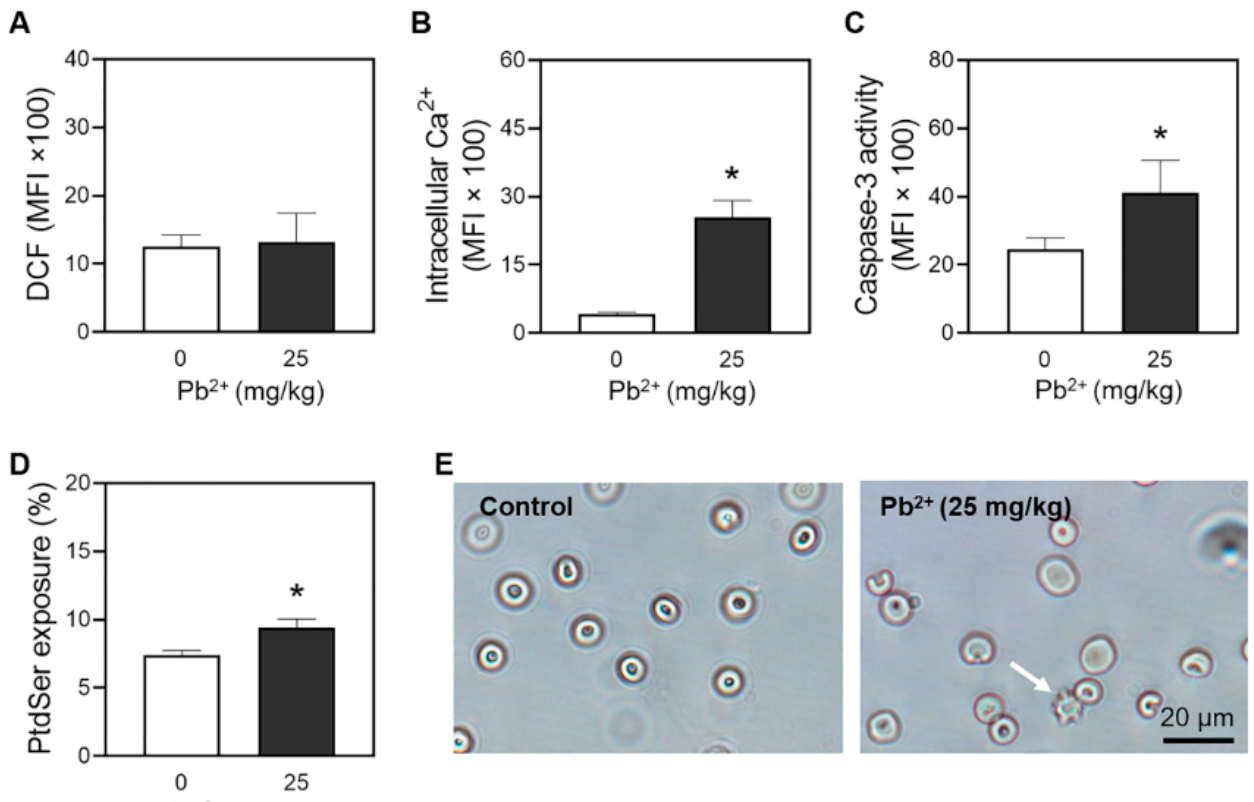
Figure 6. Pb-induced eryptosis in mice. After 25 mg/kg of Pb was exposed to mice for 1 h, ( A ) ROS, ( B ) intracellular calcium, ( C ) caspase 3 activity as well as ( D ) PtdSer exposure of erythroid cells in mice were all detected. In addition, ( E ) shape changes of erythroid cells were observed by using an optical microscope (white arrow: echinocytes). Values are the mean ± SD of 3–5 experiments. * Statistical difference compared with control ( p < 0.05).